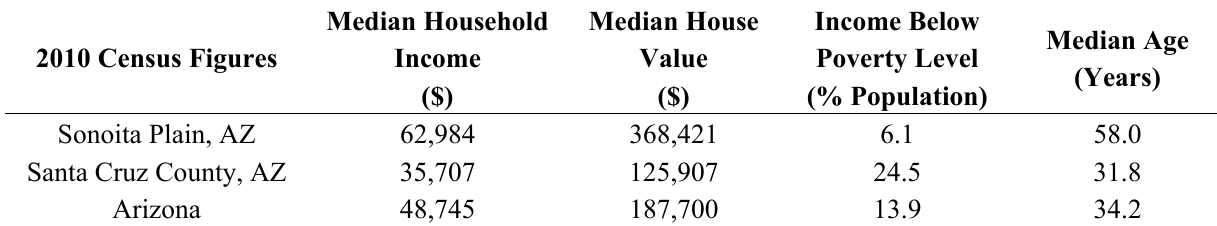
Table 1. Comparison of income, house value and resident age in the Sonoita Plain, Santa Cruz County, AZ, and the state of